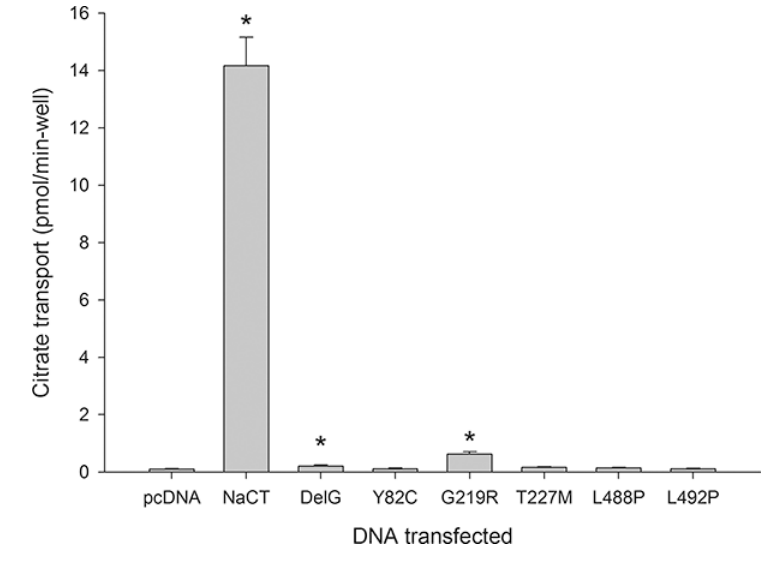
Figure 2. Transport activity of hNaCT wild-type and mutant transporters expressed in COS-7 cells. 14 C-citrate transport (100 μ mol/L) was measured at 37°C for 30 min. Data are means ± SEM, n = 8 (pcDNA and G219R), n = 7 (wild-type NaCT), n = 5 (DelG) and n = 3 (all others). * denotes p < 0.05 relative to pcDNA (empty vector plasmid) group.